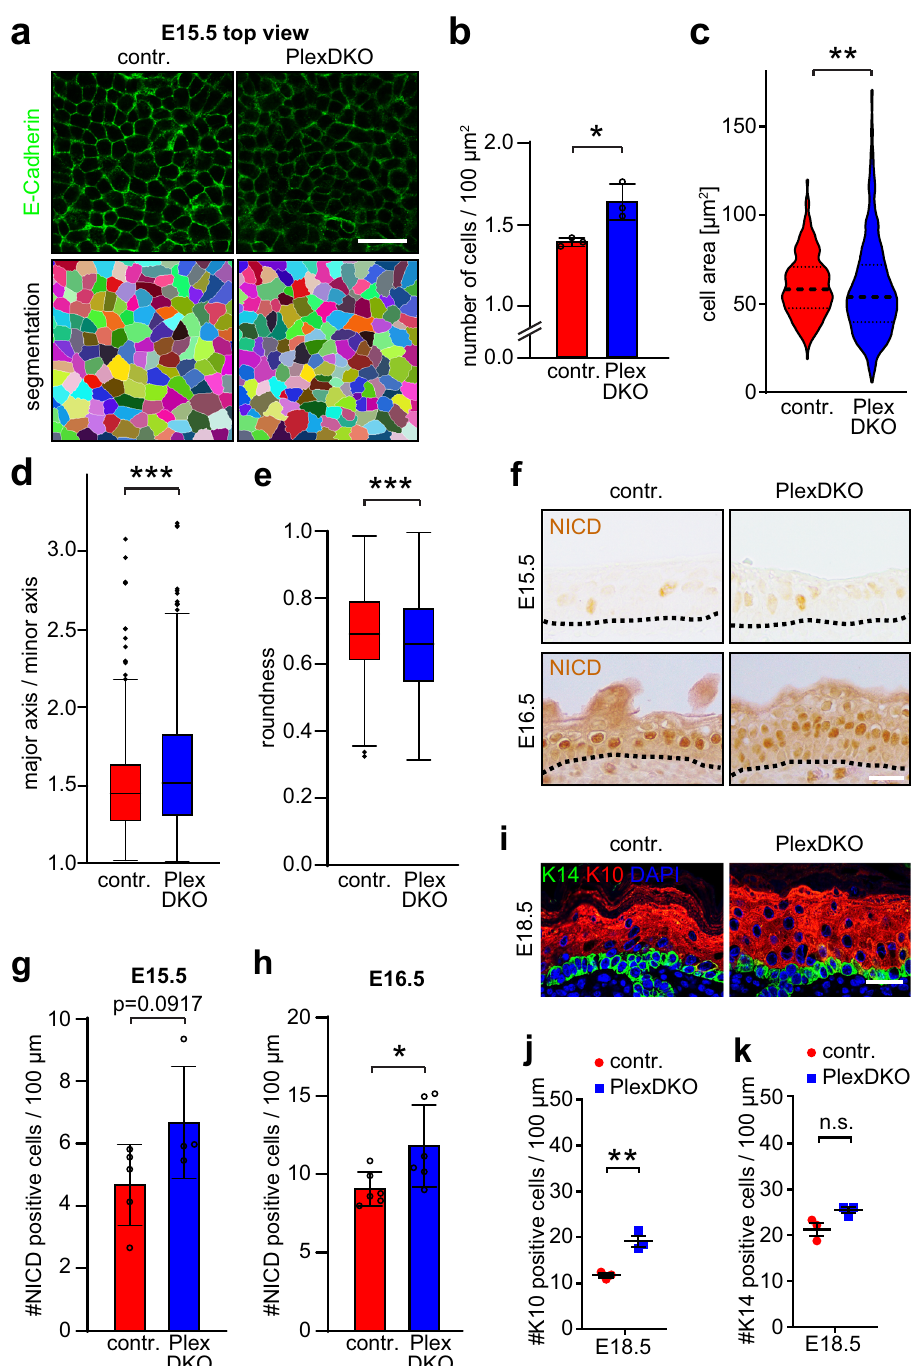
Fig. 2 Hyperproliferation of Plexin-B1/Plexin-B2 double-de fi cient epidermal stem cells induces overcrowding, cell shape anisotropy and differentiation. a Upper row: Confocal images of whole-mount immunostainings (top view) of murine epidermis at E15.5 using an anti-E-cadherin antibody (green). Shown are representative images of the basal cell layer. Lower row: Segmentation analyses of the images depicted in the upper row. Scale bar, 25 µ m. b Quanti fi cation of the number of epidermal stem cells (basal layer) per area (mean ± s.d.; n = 3 mice per genotype; p = 0.0199; two-sided unpaired t